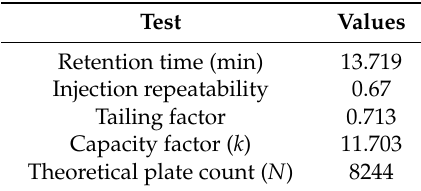
Table 2. HPLC system suitability tests for vanillyl butyl ether.